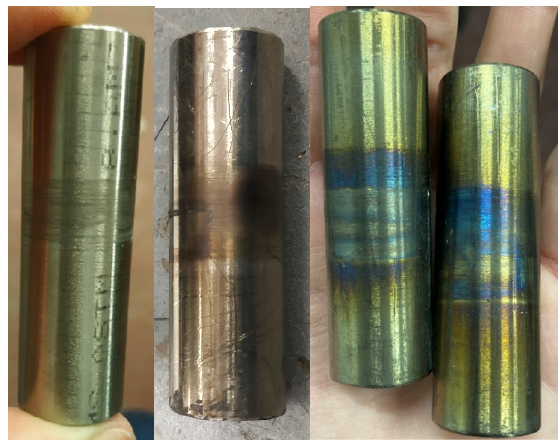
Figure 28. Pin state when exposed up to 140 °C ( left ), up to 500 °C ( middle ), and at 600 °C ( right